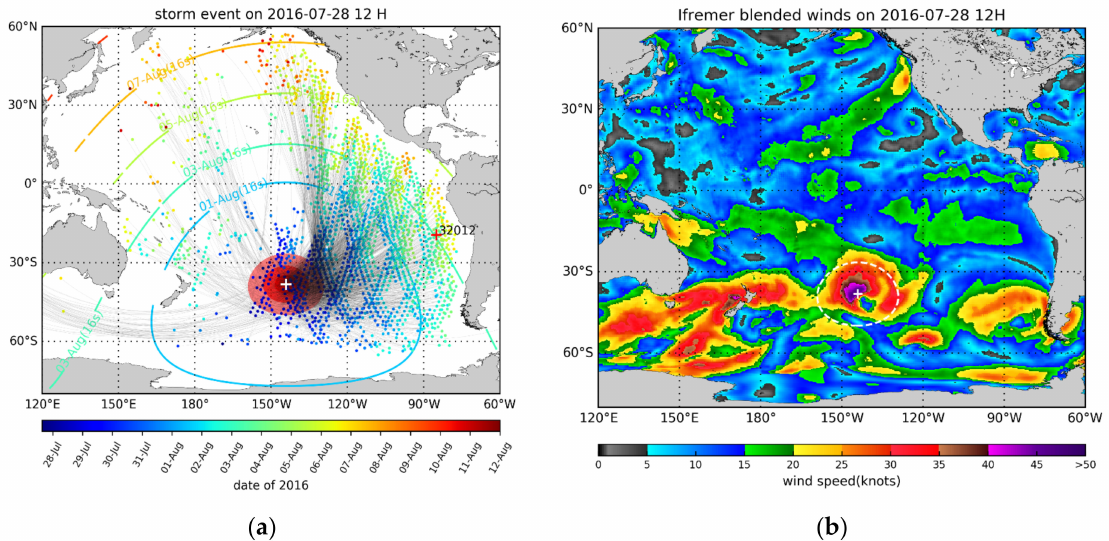
Figure 3. ( a ) Illustration of “fireworks” analysis for the case of extra-tropical storm (28 July 2016 12:00 UTC, centered at 38.22 ◦ S/144.09 ◦ W) generated swell event. Trajectories (gray lines) of Sentinel-1 swell observations (colors indicating the acquired time) associated to the storm (white plus and red disk represent storm center and coverage). The colored solid lines represent the swell predicting location at different arrival times from the swell source. ( b ) Ifremer blended winds on 28 July 2016 12:00 UTC. The center and size of swell generation area for this event inferred from the “fireworks” are represented by a white plus and dash line.